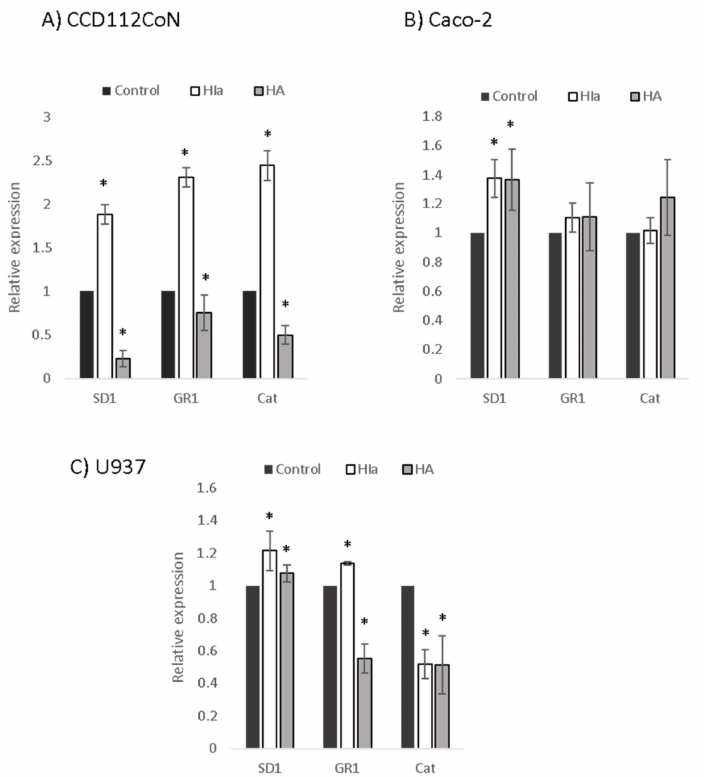
Figure 5. Expression levels of antioxidative enzymes. RT–PCR was performed to analyze the expressions of superoxide dismutase 1 (SD1), glutathione reductase 1 (GR1), and catalase (Cat) in ( A ) CD112CoN, ( B ) Caco-2, and ( C ) U937 cells. 18S rRNA was used as an endogenous control; the relative gene expression of non-treated cells was set to one, * p <